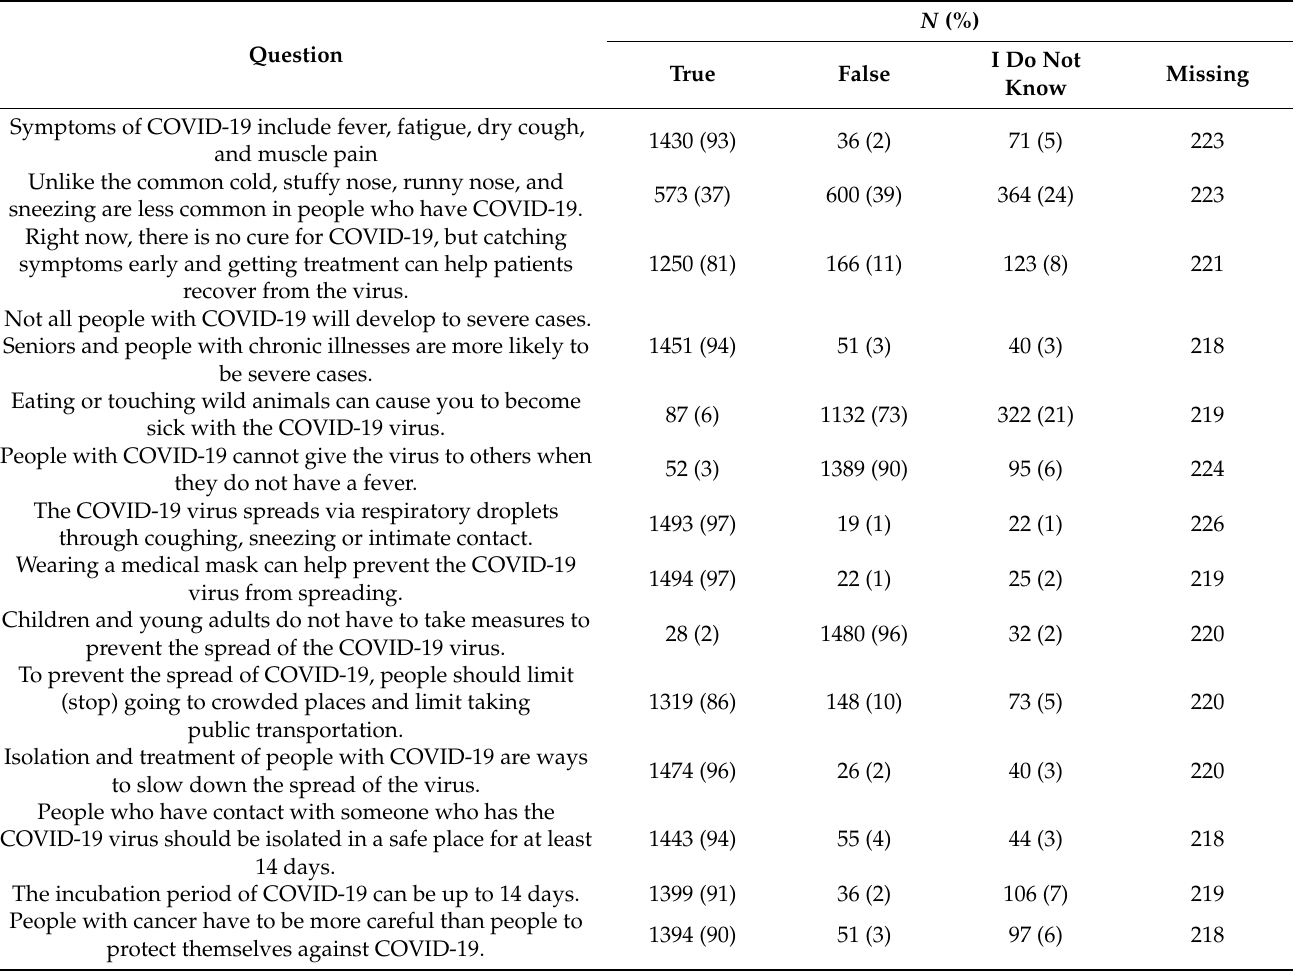
Table 6. Knowledge about